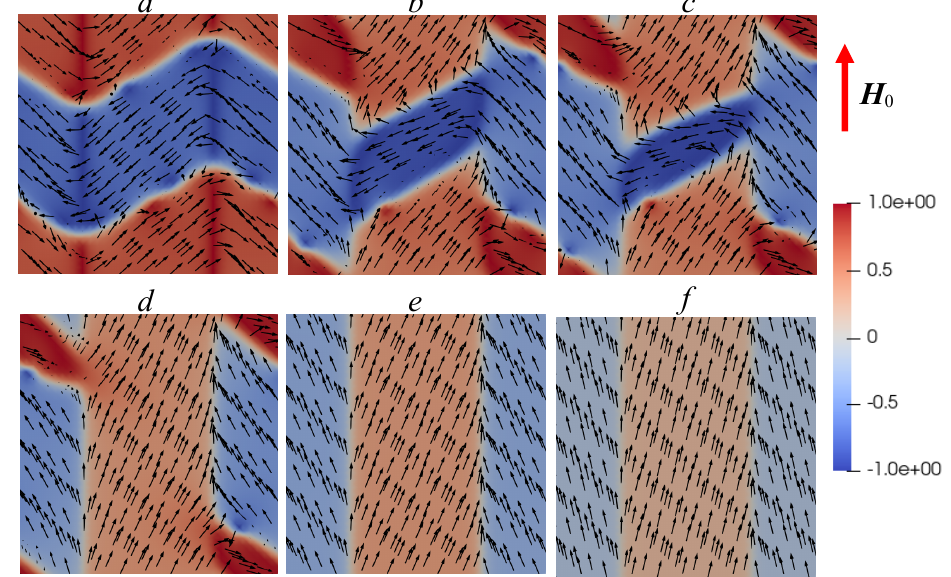
Figure 4. Evolution of the magnetization vector upon application of an external magnetic field along the y axis: ( a )— ˜ H 0 = 0, ( b )— ˜ H 0 = 0.25, ( c )— ˜ H 0 = 0.3, ( d )— ˜ H 0 = 0.32, ( e )— ˜ H 0 = 0.33, ( f )— ˜ H 0 =